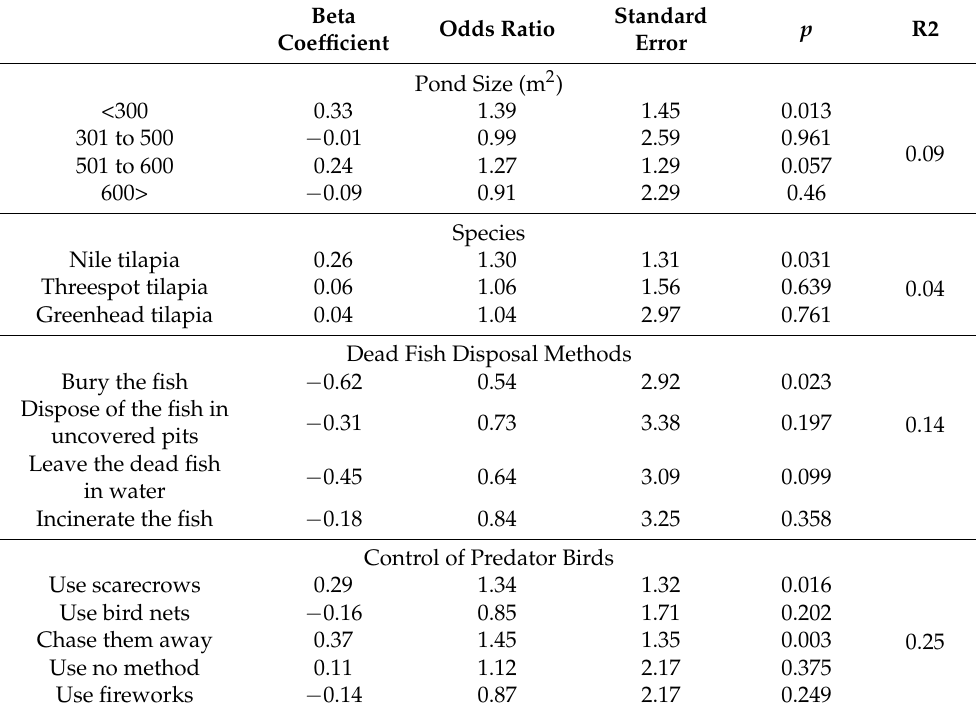
Table 6. Factors associated with a high total cumulative mortality on farms.